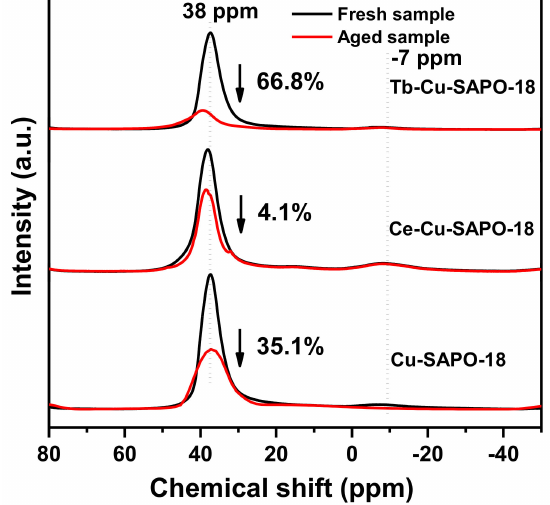
Figure 10. 27 Al NMR spectra of before (black line) and after (red line) hydrothermally aged Cu-SAPO-18 and M-Cu-SAPO-18 (M = Ce or